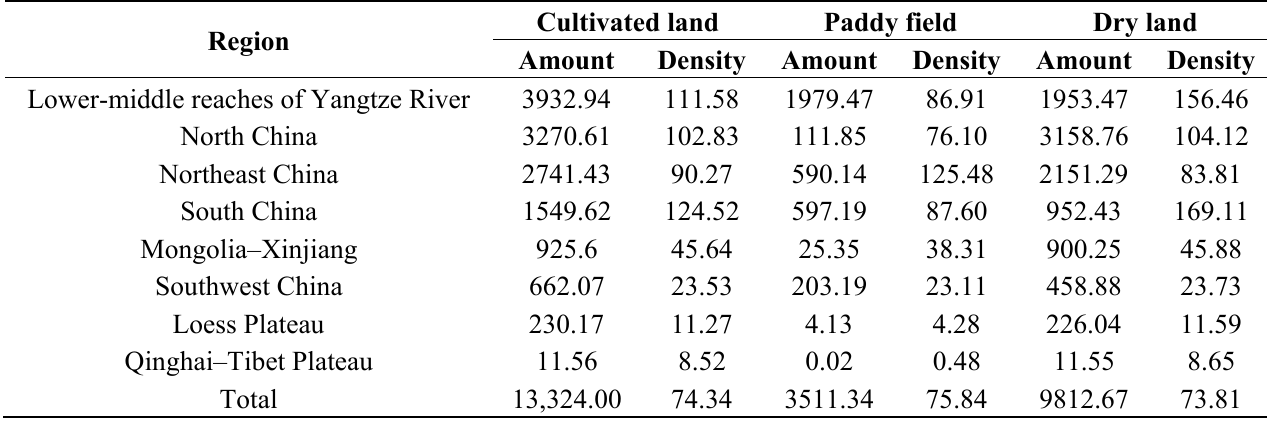
Table 4. Amount (1 × 10 4 t) and density (t/km 2 ) of CR areas in each